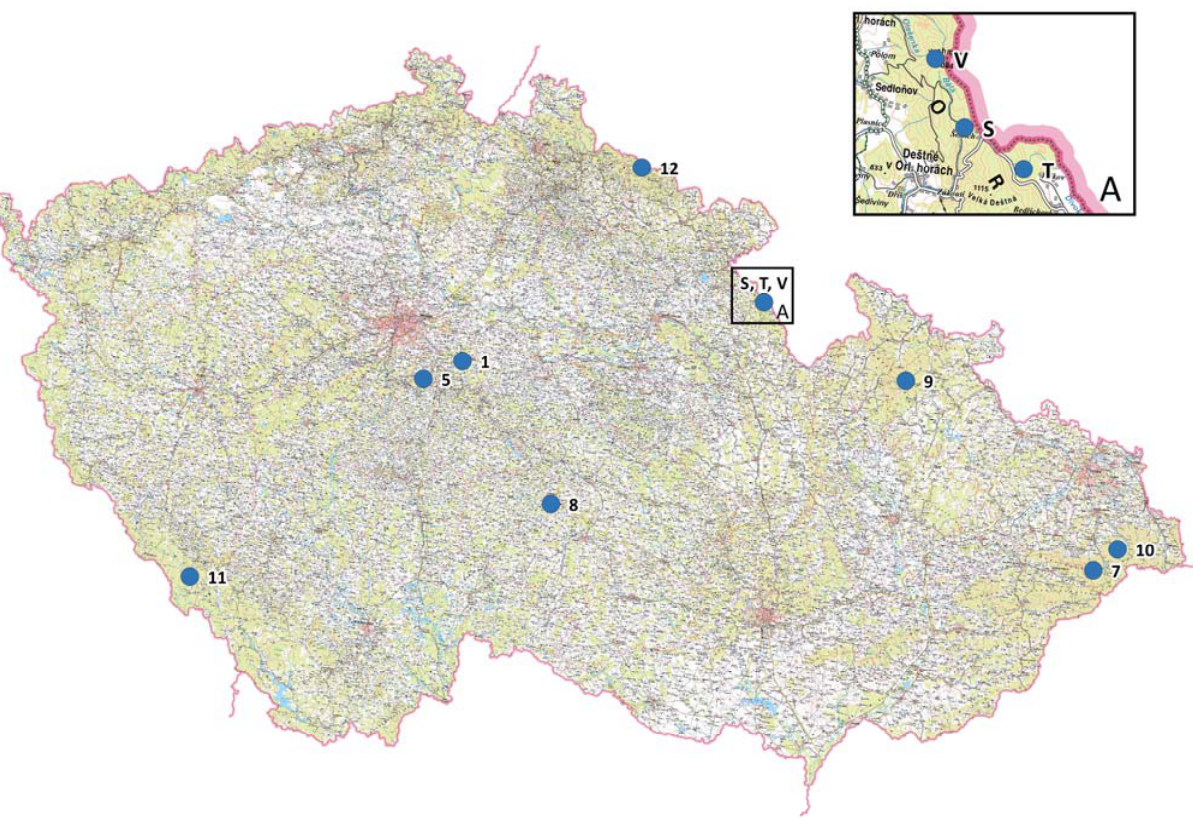
Figure 1. Geographical locations of the Picea abies units.